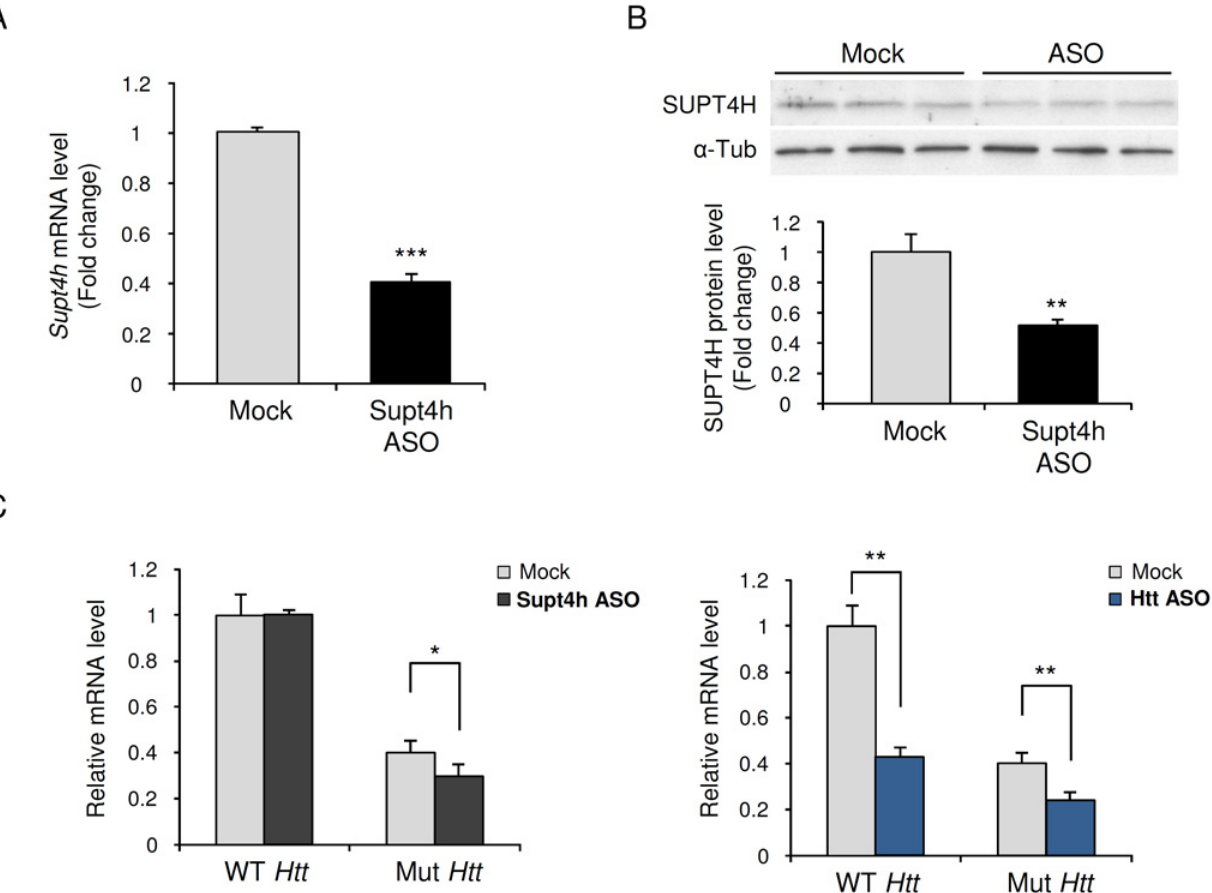
Fig 1. Effect of down regulation by Supt4h ASO on expression of mutant and wild-type Htt alleles in zQ175 HD mice. Supt4h ASO was delivered to the brain of zQ175 HD mice by intracerebroventricular (ICV) bolus injection. ASO became distributed throughout CNS via cerebral spinal fluid circulation, and as observed previously [18] the spinal cord most susceptible to its effects. Mice were sacrificed 4 weeks after a single injection at the age of 5.5 months and spinal cords were collected for analyses of ASO effects. (A) Supt4h transcript abundance was assessed by quantitative RT-PCR. mRNA level in tissue obtained from PBS-treated zQ175 mice (mock) was set to 1, and relative Supt4h mRNA level in tissue from ASO-treated animals is shown. (B) SUPT4H protein level in tissue analyzed in (A) for mRNA abundance was examined by Western blot analysis. After normalization using α -Tubulin, the protein level was compared to mock control. (C) Left, wild-type (WT) and mutant (Mut) Htt gene expression were assessed by qRT-PCR in Supt4h ASO-treated samples and compared to that of mock samples. The level of WT Htt mRNA in mock samples was set as 1, and Htt transcripts produced from the co-existing Mut allele were approximately 40% of WT mRNA obtained from zQ175 KI mice. Right, production of wild type and mutant Htt mRNAs following intracerebroventricular bolus injection of an ASO [18] that targets both the WT and Mut alleles of Htt . The conditions used for injection and analysis in these experiments were identical for those employed for the ASO targeting Supt4h (n = 3 in each group; * , p < 0.05; ** , p < 0.01; *** , p < 0.001 by Student ’ s t